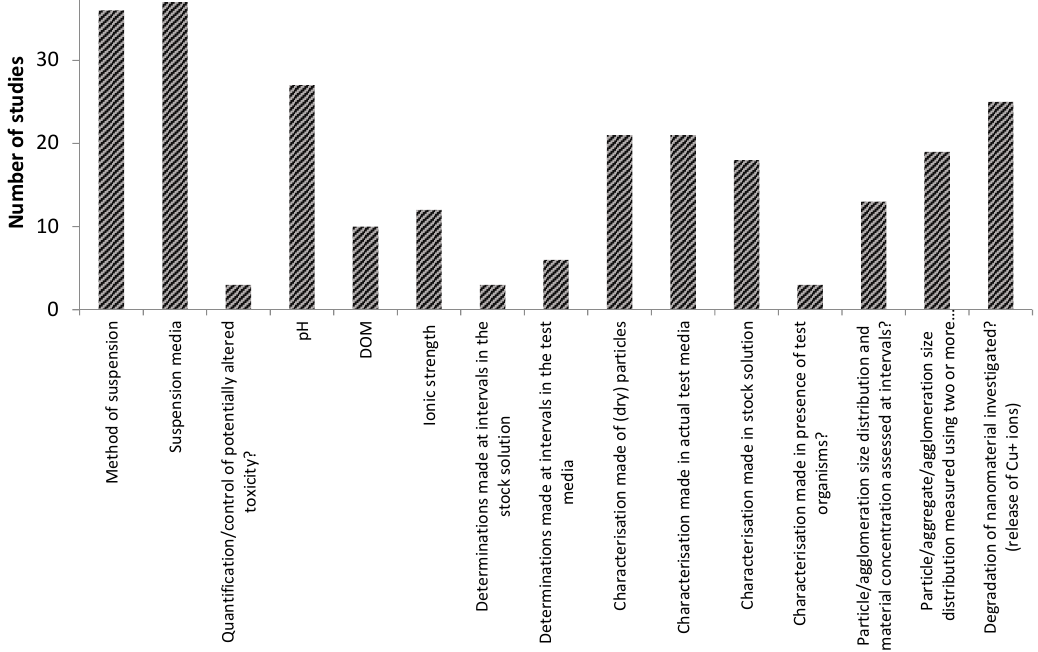
Figure 2. Number of ecotoxicity studies on copper oxide nanoparticles considering the reporting and characterization parameters recommended in the Organisation for Economic Co-operation and Development (OECD) guidance document [18].